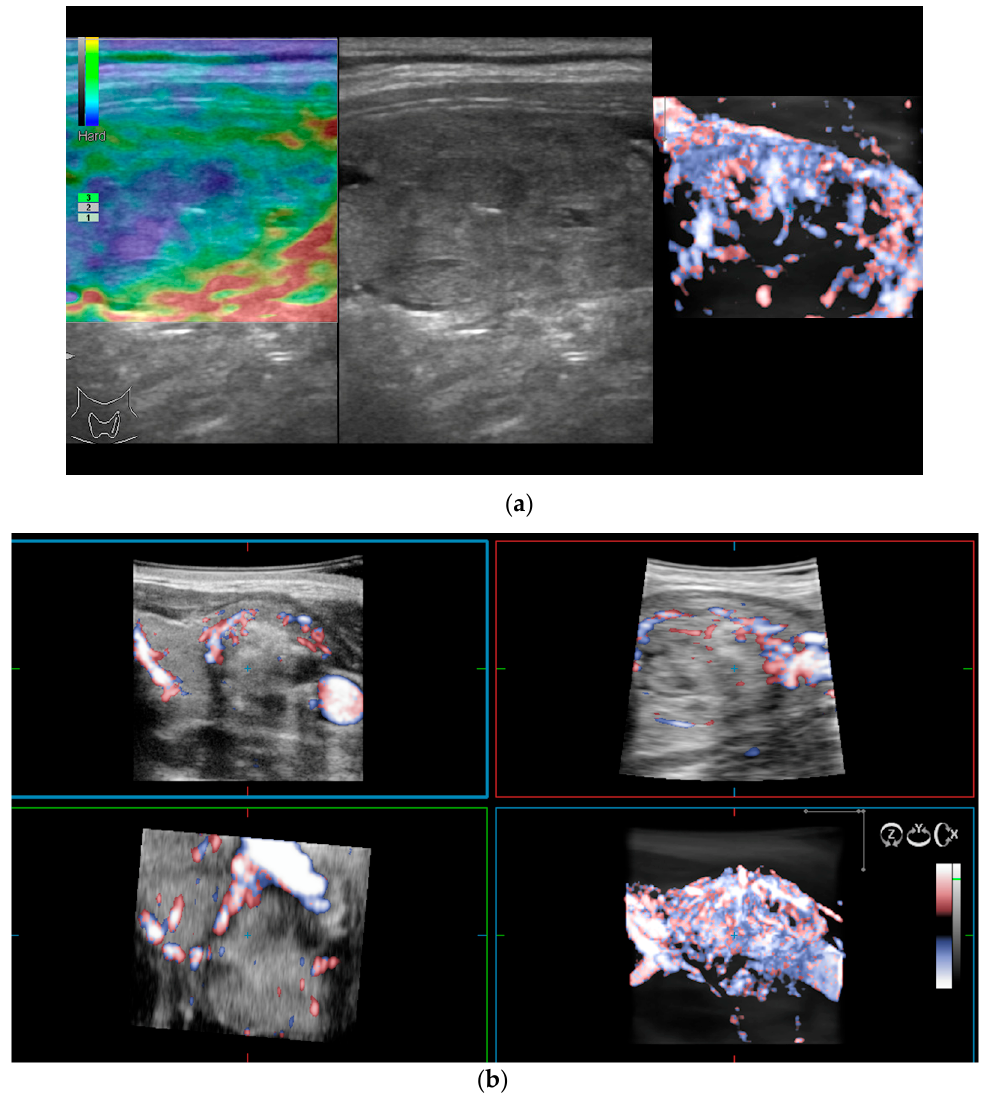
Figure 2. ( a ) Risk upgrade: Strain elastography + 4D vascularisation; ( b ) 4D Color Doppler Risk upgrade: Intermediate -> High.